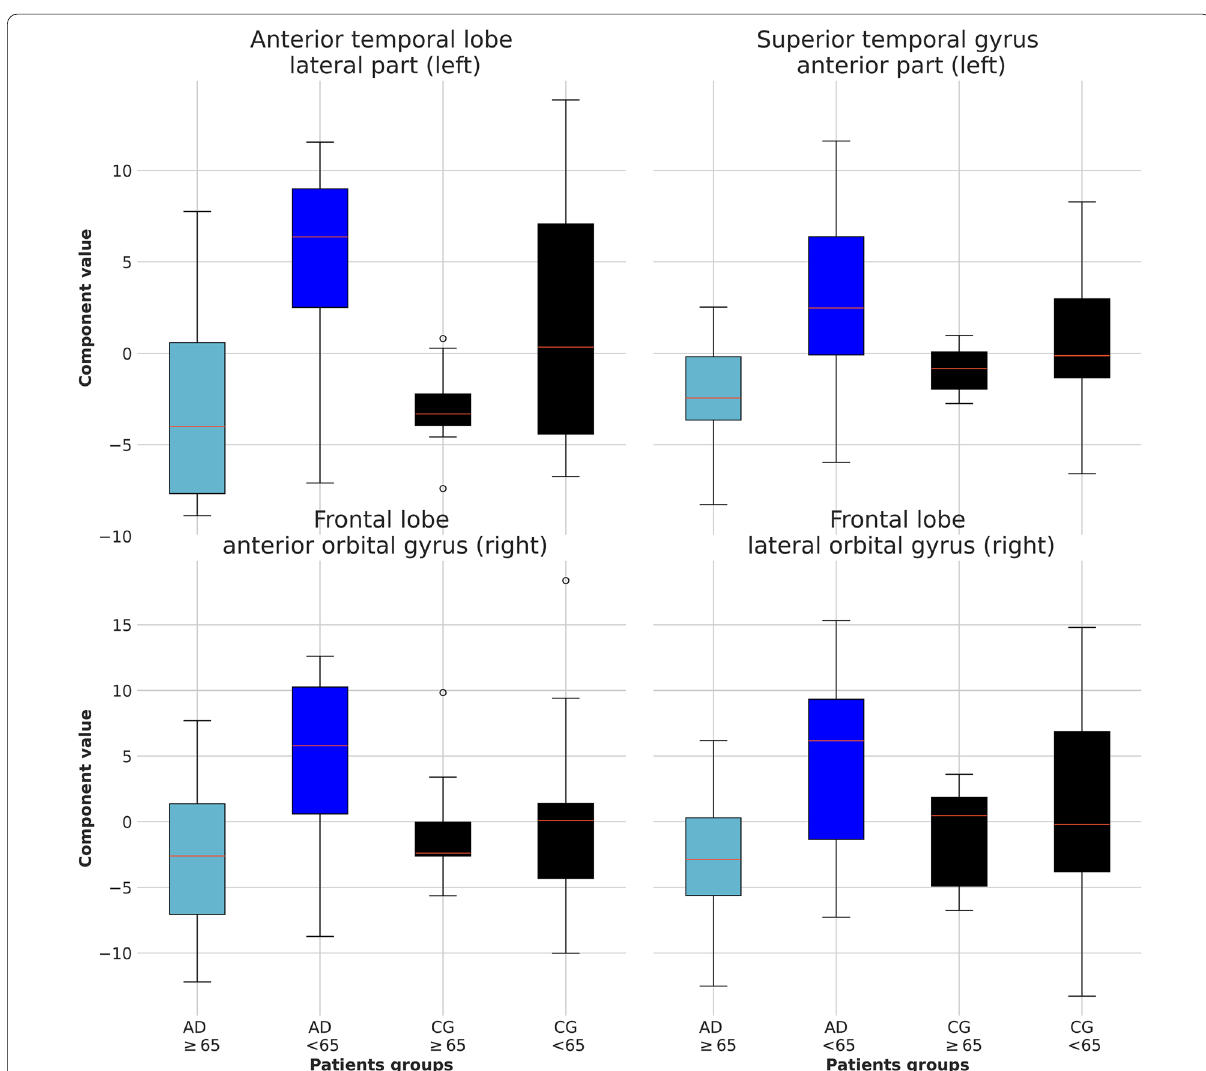
Fig. 6 Candle plot in the temporal lobe and the frontal lobe for LOAD, EOAD, and background estimated from control subjects. Candle plots of the distribution of the significant principal components for LOAD, EOAD, and background from control subjects. The age of onset of AD is classified according to the threshold age A 65. The average value of the parameters for EOAD patients exhibits difference with respect to LOAD and = background estimated from control subjects, in support to the assumption that the identified principal components describe intrinsic early-onset features of the spatial distribution of the A β deposition in [ 18 F]florbetaben